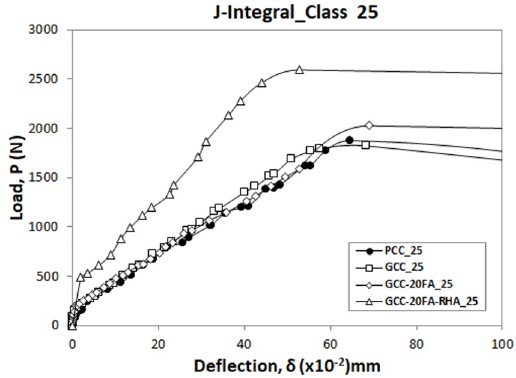
Figure 10. Average values of load-deflection curves in the middle of the span of the class 25 notched beams of different matrices.